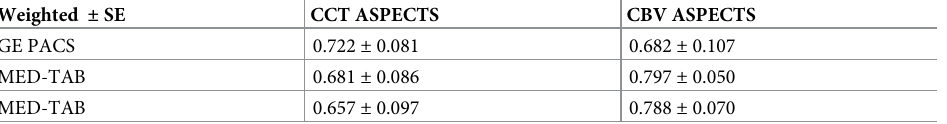
Table 5. Interrater agreement for CCT and CBV ASPECTS between the senior and the resident on all three devices.